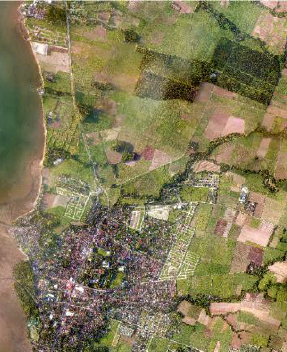
Figure 1. Orthophoto of the study site taken in June